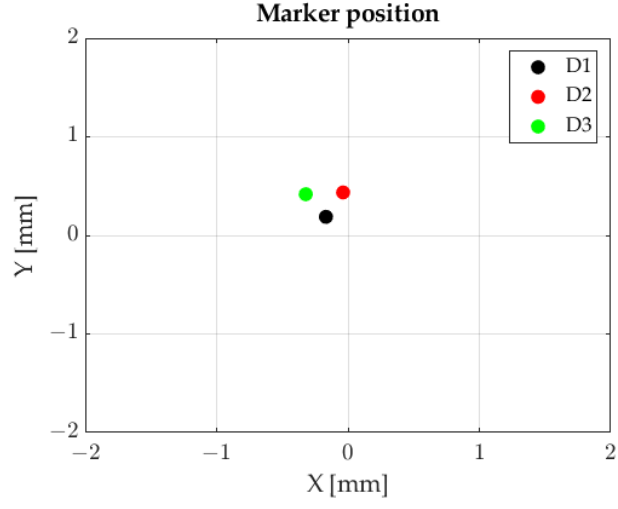
Figure 10. Markers’ positions, sequential marker control method. Figure 10. Markers ’ positions, sequential marker control method.